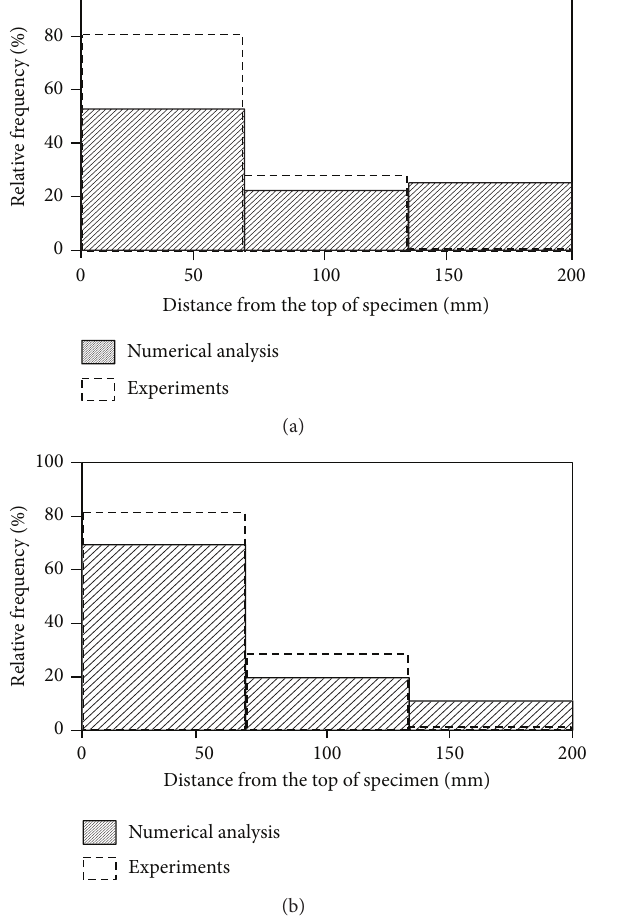
Figure 8: Probability of cracking with the maximum stress COV of 10% when considering the variations of modulus of elasticity and cracking strength along the specimen (a) using (12) and (b) using